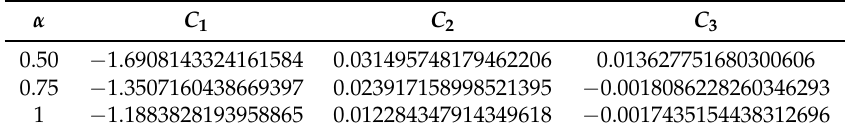
Table 11. Auxiliary Convergence-constants for dissimilar values of α of Example 3.